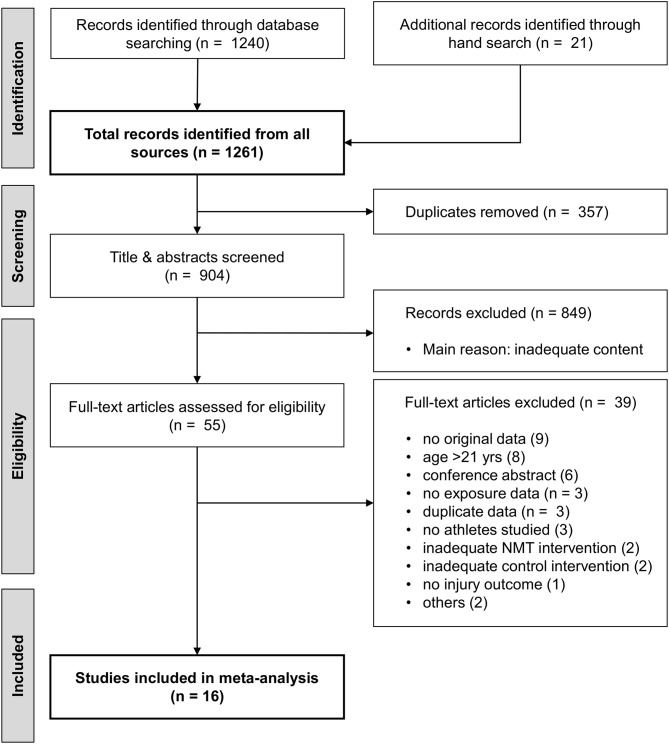
PRISMA flow chart.